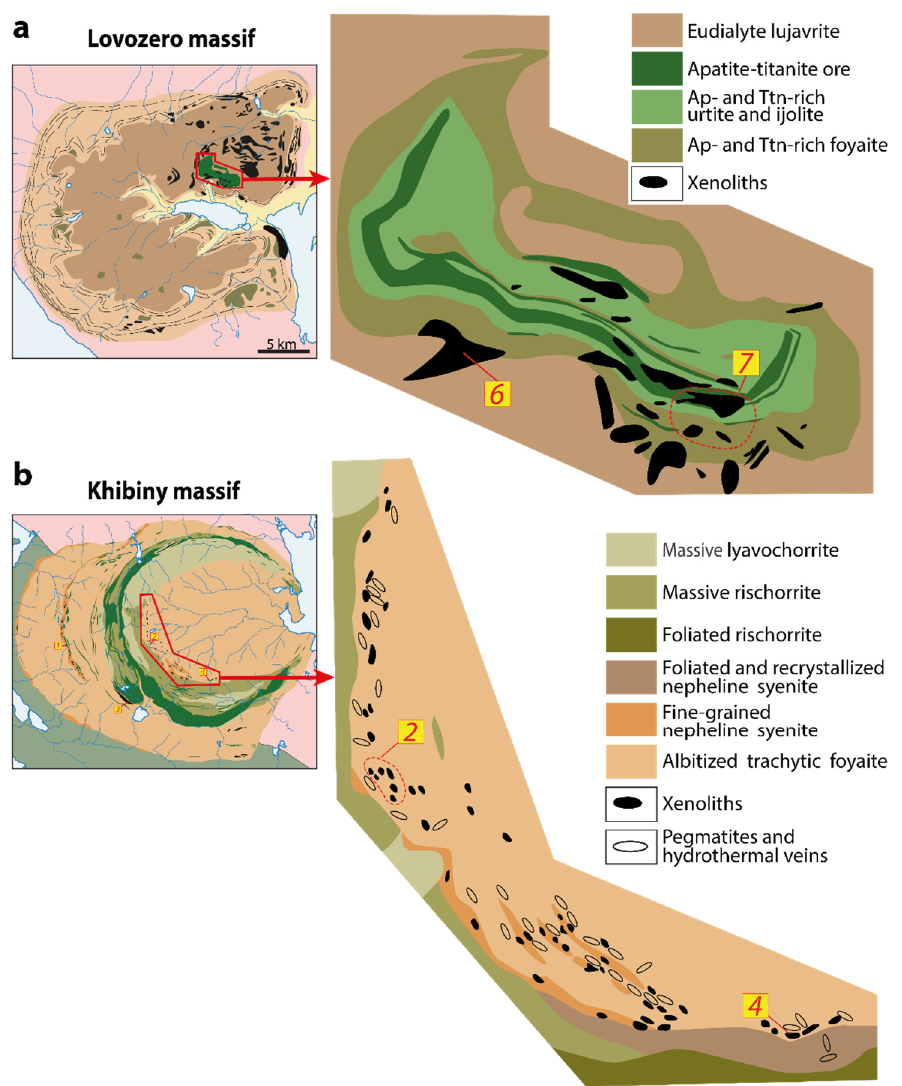
Figure 3. Schemes of the location of xenoliths of aluminous hornfelses in the Lovozero and Khibiny massifs. ( a ) part of the Eudialyte complex of the Lovozero massif (outlined in red), where xenoliths of the aluminous hornfelses are located [27]; ( b ) xenoliths of the aluminous hornfelses in the central part of the Khibiny massif [39]. 2, 4, 6, 7 are sampling points (see Figure 1b).